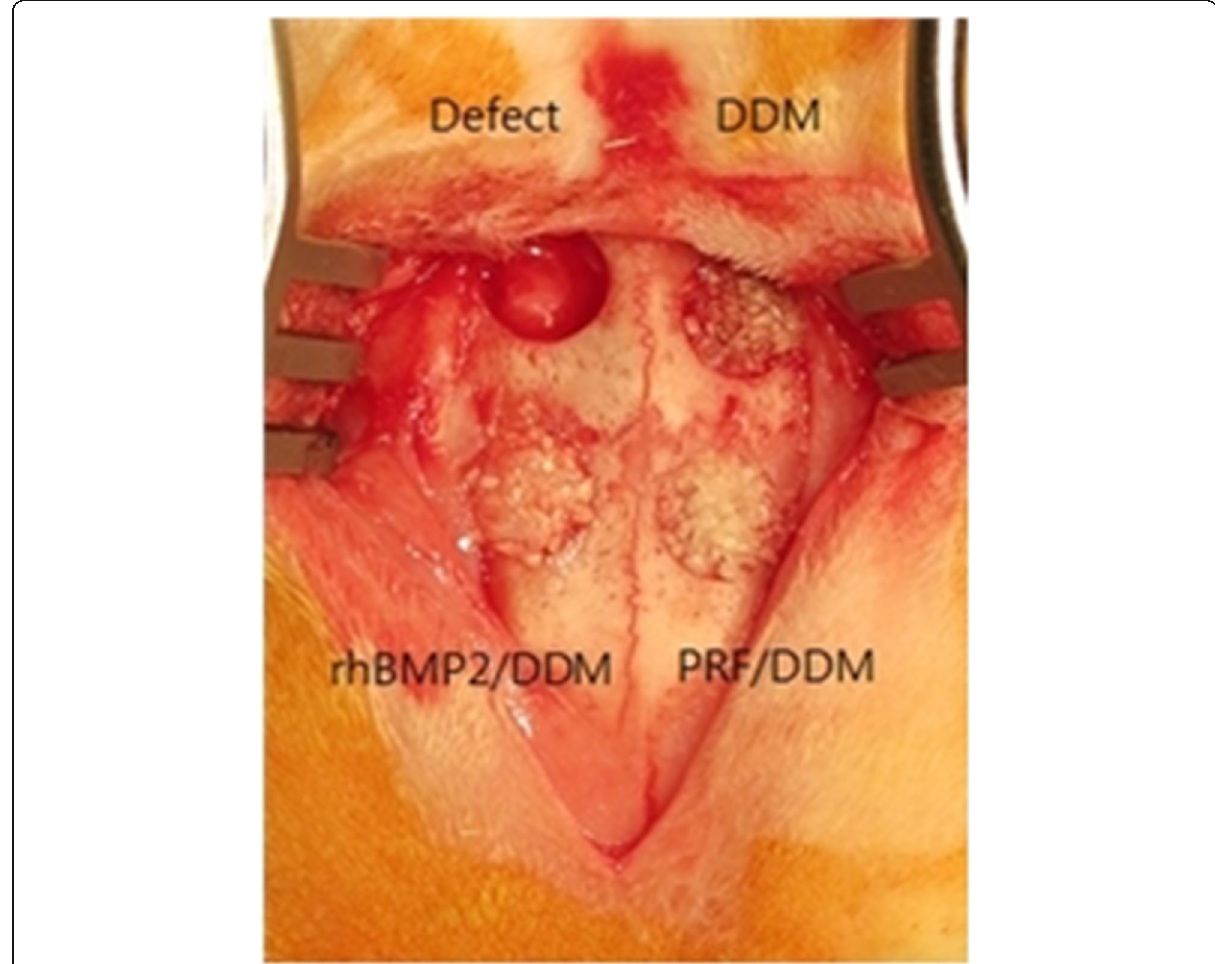
Fig. 1 Experimental design. The control group received manual pressure hemostasis with gauze and did not receive any graft into the calvarial defect. In experimental group 1, bone defects were treated using DDM as a sole grafting material. Experimental group 2 were treated with a mixture of PRF and DDM. Experimental group 3 were treated using DDM with absorbed